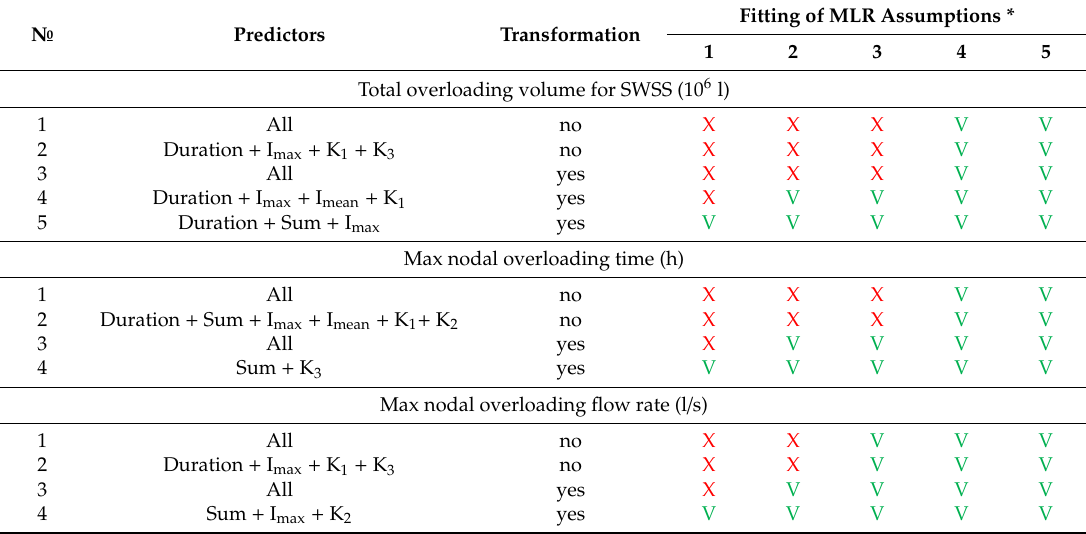
* 1. Linear relationship and independent predictors, 2. Symmetrical (normal) distribution of predictors, 3. Normality of the model residuals, 4. Non-autocorrelation of the model residuals, 5. Homoscedasticity of model variance. Red crosses and green ticks denote to fail / fit of the